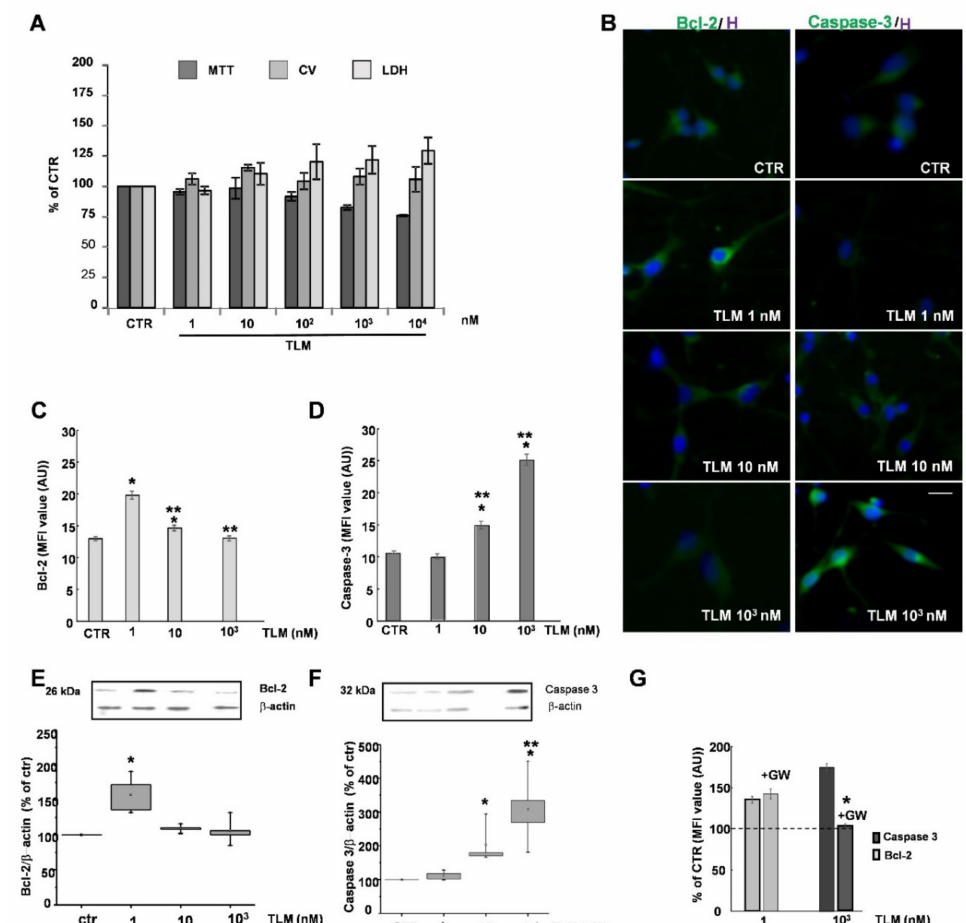
Figure 1. TLM modulates cell viability and anti- or proapoptotic cellular events. OP cultures were exposed for 24 h to different TLM concentrations (from 1 to 10 4 nM). ( A ) Cell viability, total cell number, and cytotoxicity were evaluated by MTT, CV, and LDH assay. Means ± SEM are shown as percentage of control ( n = 3–4; p = 6 × 10 − 5 for MTT and p = 0.0404 for LDH, one-way ANOVA). IF and WB techniques were used to assess BCL-2 ( B , C , E ) and Caspase-3 expression ( B , D , F ). Scale bar = 30 µ m. The Means of fluorescence intensity (MFI) from 200–250 cells/condition/experiment are shown in ( C , D ). Representative WB of Bcl-2 or Caspase-3 and β -actin are shown ( E , F ). Band intensities are shown as % of CTR. β -actin is used as an internal control. Means ± SEM ( n = 3; * p < 0.001 vs. CTR, ** p < 0.05 vs. 1 nM TLM, unpaired two-tailed Student t -test).The effect of PPAR- γ antagonist GW9662 (GW) is shown in ( G ) ( n = 3, on 300–350 cells/experiment; * p < 0.005, unpaired two-tailed Student t